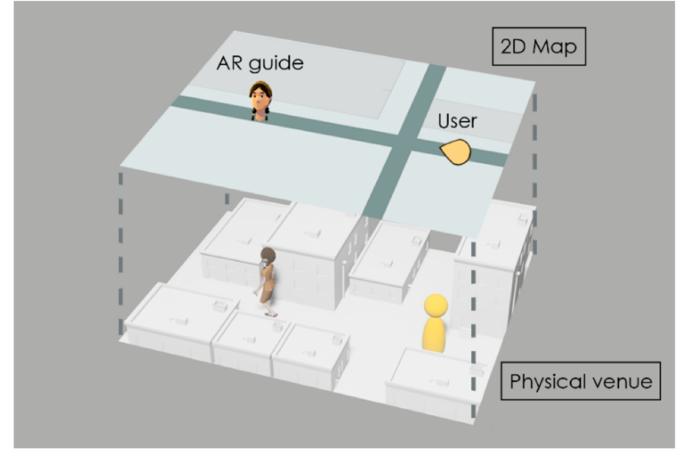
Figure 1. Schematic diagram of cyber-physical